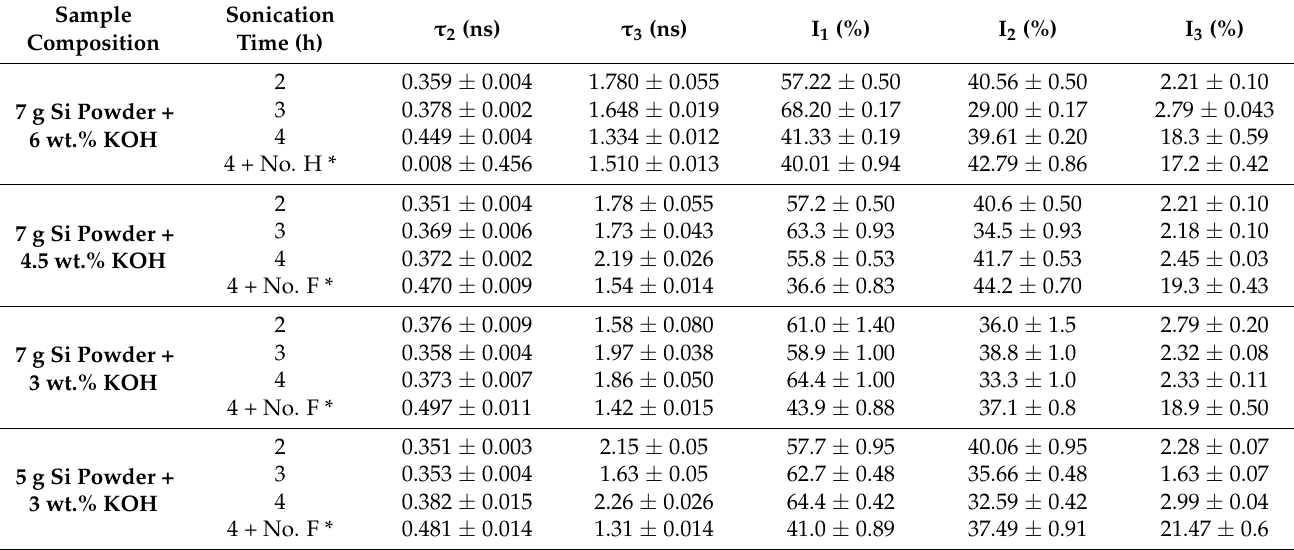
Table 1. The results of lifetime components with the corresponding intensities at 7 and 5 g of commercial silicon powder in different weight of KOH (wt.%) at sonication times of 2, 3, and 4 h). Sample